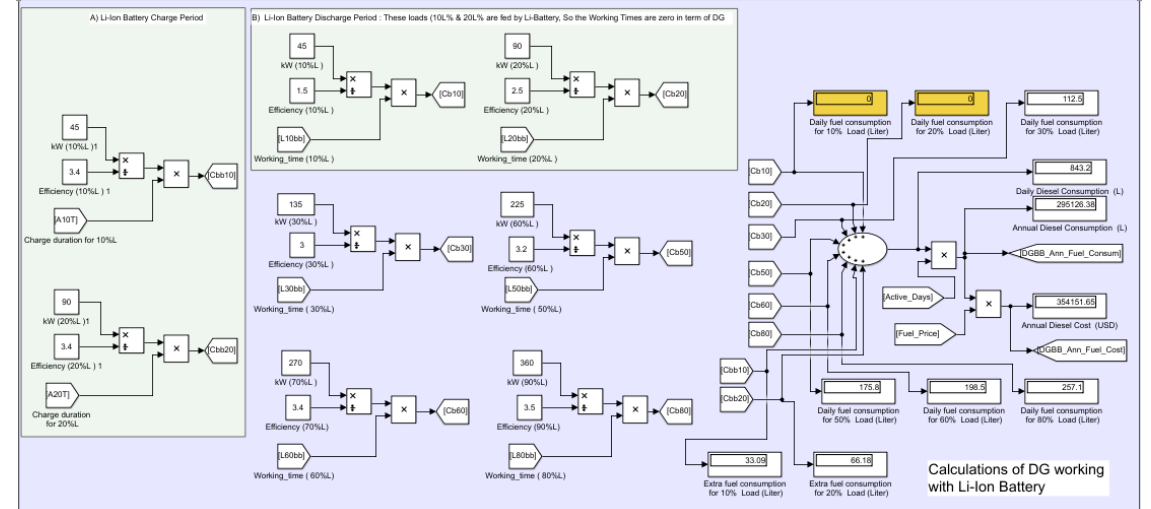
Figure 7. Calculation block for DG operation with Li-ion battery.